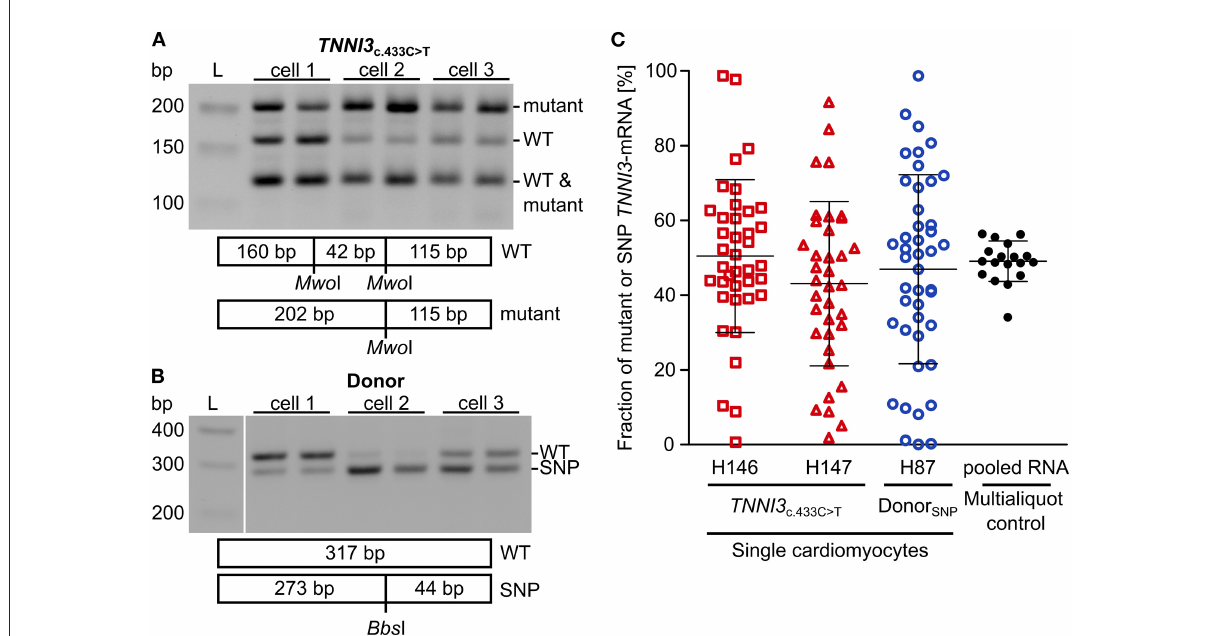
FIGURE2 Allelic imbalance of TNNI3 in cTnI R145W patient and donor cardiomyocytes. Individual cTnI R145W cardiomyocytes and donor cardiomyocytes were isolated by laser-microdissection from cryosections and reverse transcribed. cDNA was split in two technical replicates and subjected to nested PCR. (A) RT-PCR-products from single laser-microdissected cTnI R145W cardiomyocytes were treated with Mwo I to generate allele-specific restriction fragments. Shown are three different cells in technical replicates. Expected fragment sizes are 202 bp for TNNI3 c.433C > T -allele, 160